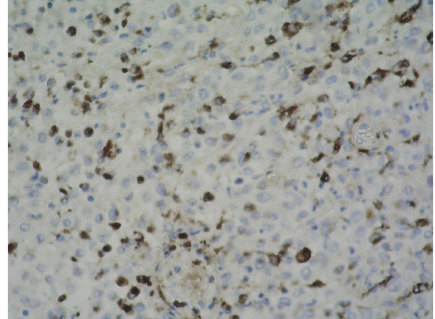
Figure 4: Langerhans cells staining positive for CD68 on immuno- histochemical staining ×